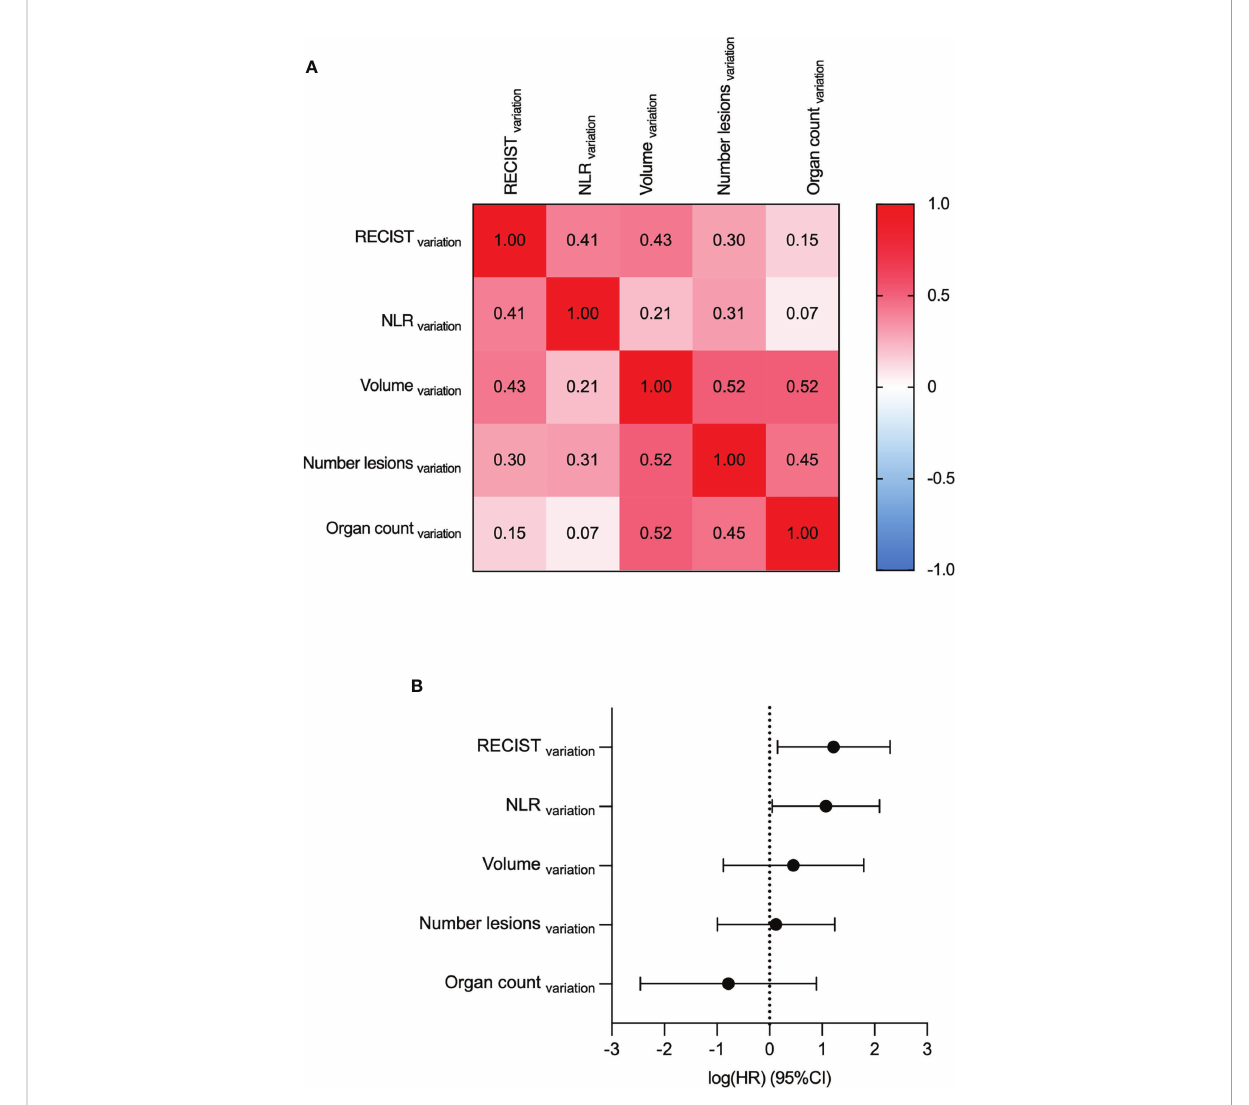
FIGURE 5 Multivariate analyses determine RECIST variation and NLR variation as the most predictive variables for OS. RECIST variation , NLR variation , Volume variation Number lesions variation and Organ count variation were compared by multivariate analyses. (A) The Spearman correlation coef fi cients. (B) Log- hazard ratio (HR) according to each covariate. Data are shown as HR (95%